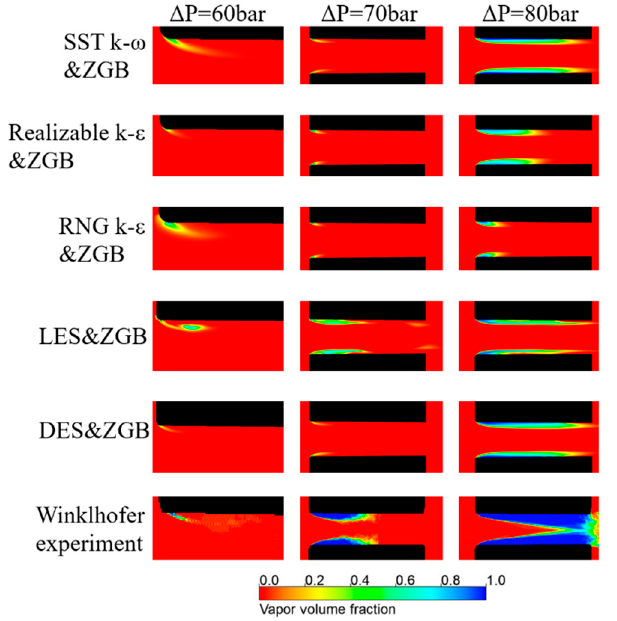
Figure 6. Comparison of cavitation distribution regions at microchannels under different turbulence models.